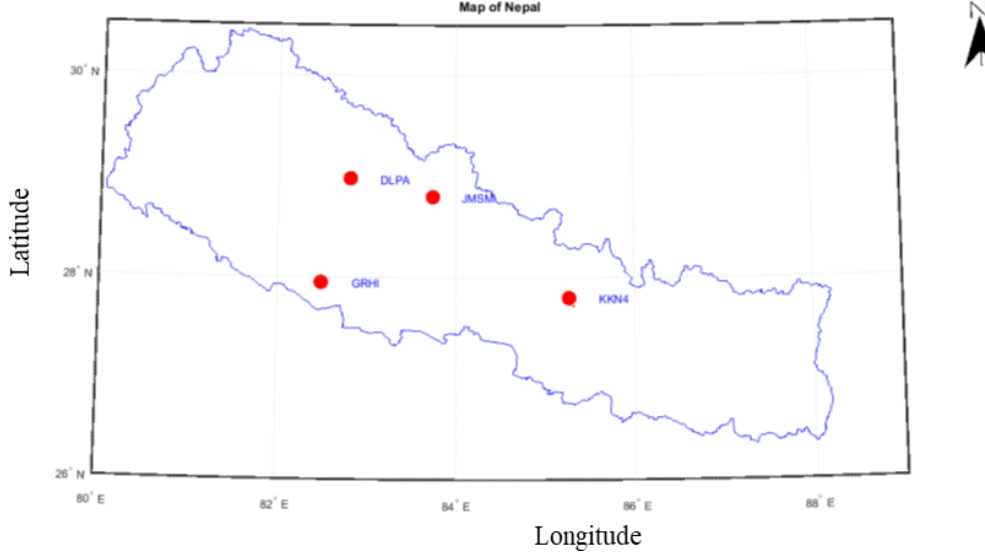
Figure 1. A map of Nepal showing locations of GPS stations used in our study.